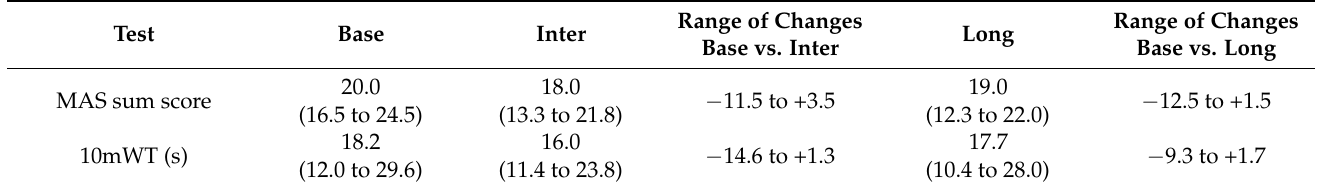
Figure 2. Intermediate and longer-lasting carry-over effects of transcutaneous spinal cord stimulation on the Modified Ashworth Scale (MAS)-based evaluation of lower-extremity muscle hypertonia. ( a ) Group results of (i) MAS sum scores obtained in Base, Inter, and Long; and (ii) changes in MAS sum scores per participant in Inter and Long compared to Base, illustrated by box plots. Bold horizontal lines within boxes are medians; boxes span the interquartile range. Whiskers extend to the lowest and largest values that are not outliers (illustrated as circles; see Methods). Brackets and asterisks denote significant results of post-hoc pairwise comparisons (*, p < 0.05; **, p < 0.001). ( b ) Changes in individual MAS scores (one score per movement, limb, and participant) in Inter and Long compared to Base. Stacked bar charts show percentage of changes classified as clinically meaningful improvement (reduction by ≥ 1; magenta sections of bars); improvement (reduction by 0.5; light magenta); unchanged (grey); and increase (black). Base, baseline evaluation comprising two assessments conducted ~24 h and immediately pre-intervention; Inter, evaluation of intermediate carry-over effects comprising two assessments immediately and two hours post-intervention; Long, evaluation of longer-lasting carry-over effects conducted ~24 h after the stimulation session; MAS, Modified Ashworth Scale. Table 2. Group results of core